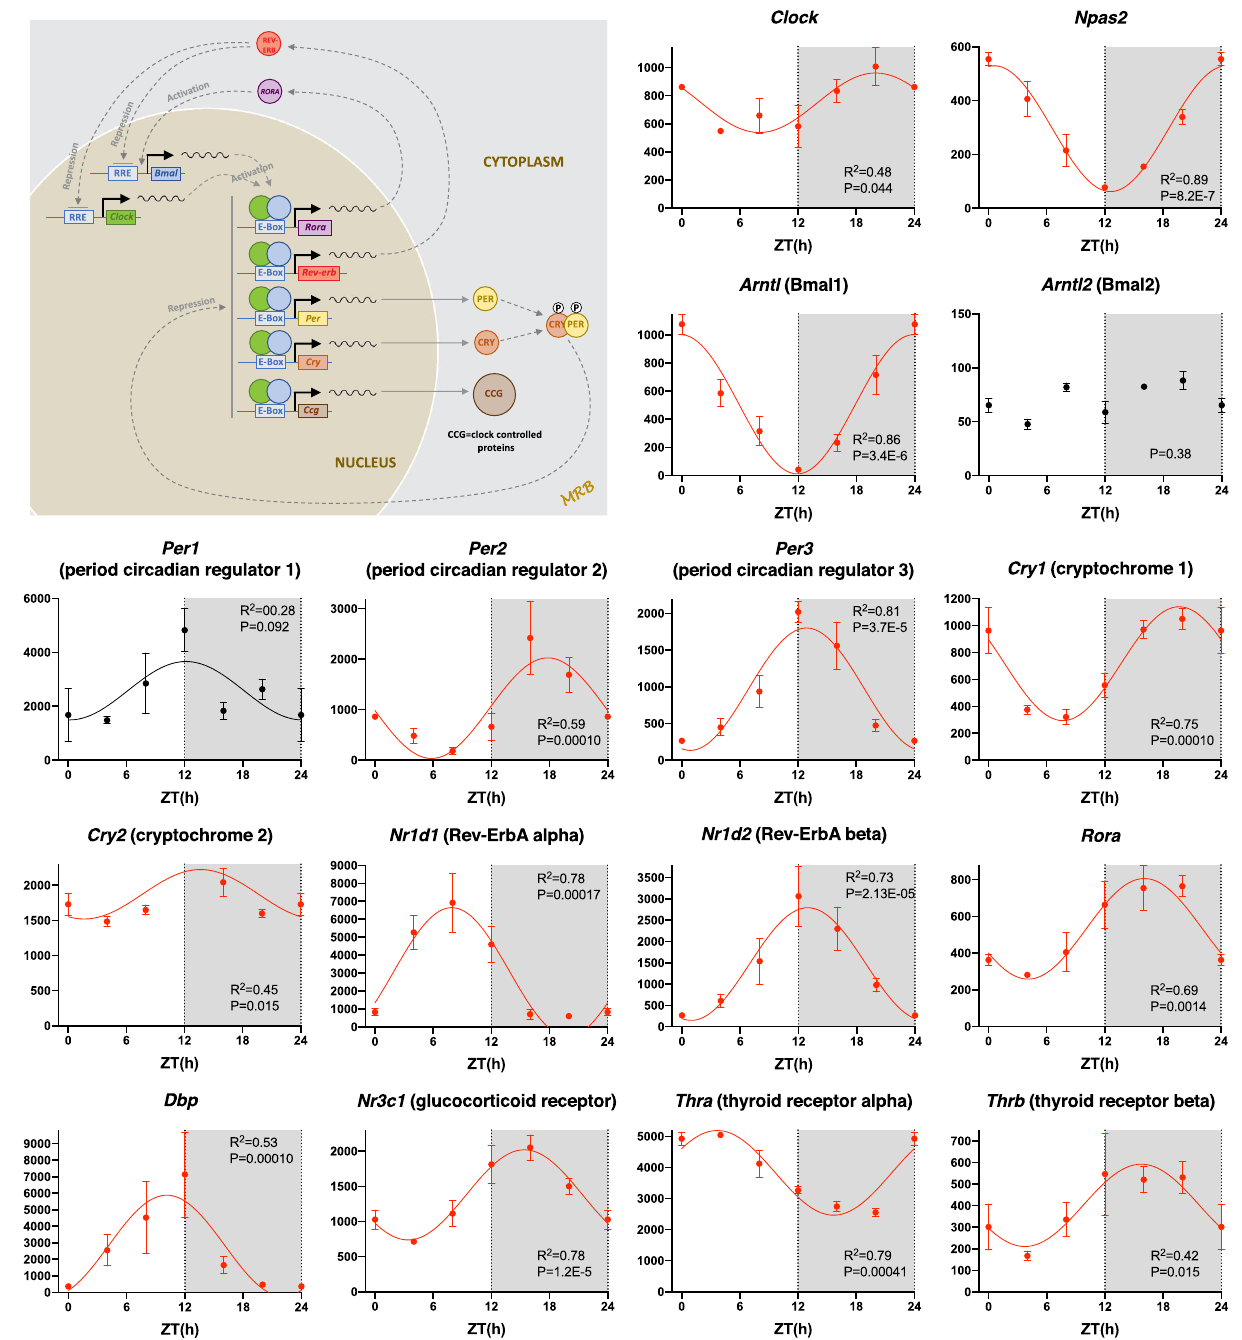
Figure 1. Circadian clock. Abundance (normalised counts) of circadian clock transcripts and some potentially related transcripts is shown over 24 h. The inset shows a schematic diagram of the circadian clock. In this and similar figures: gene name and common name (in parenthesis) given; mean ± SEM transcript abundance shown (n = 3) at six ZT time points over 24 h (24 h data repeat of 0 h data); the permutation-based P value (corrected for multiple testing) from JTK Cycle for significance of a day-night rhythm is given; significant transcripts (permutation-based P value < 0.05) are shown in red and have been fitted with a sine wave by a least squares fitting method and the R 2 value given; transcripts showing a trend towards significance (permutation-based P value > 0.05 and < 0.1) are shown in black and have again been fitted with a sine wave by a least squares fitting method and the R 2 value given; non-significant transcripts (permutation-based P value > 0.1) are shown in black and have not been fitted with a sine